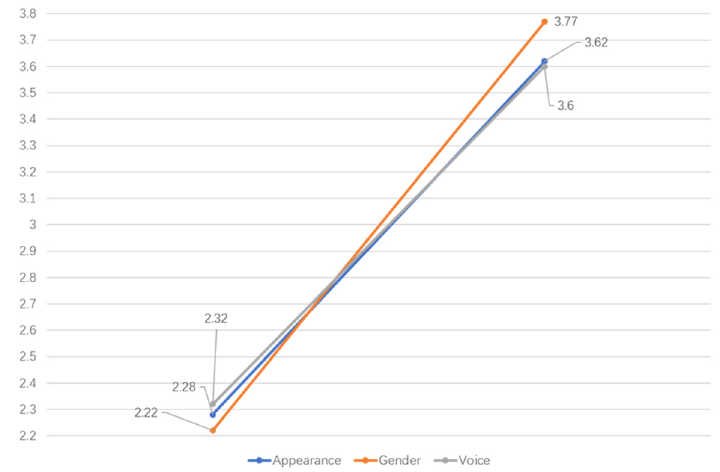
Figure 2. Estimated marginal mean of the variables.